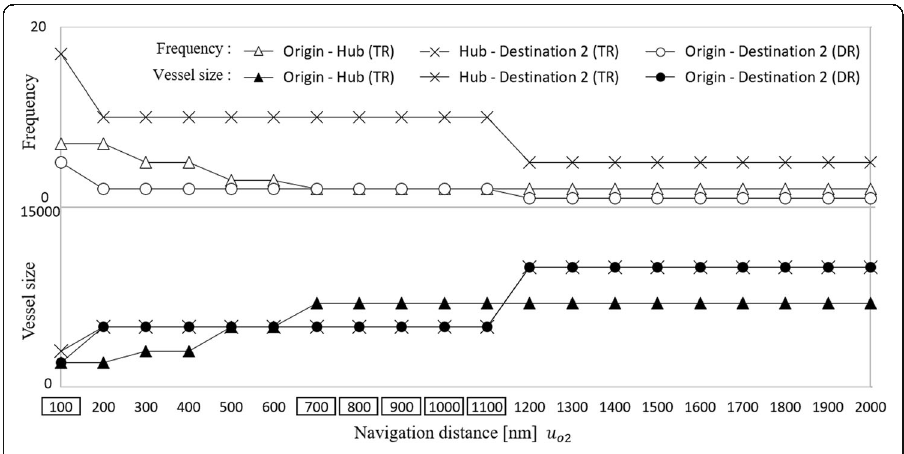
Fig. 6 Frequency and vessel size of each route in 7000